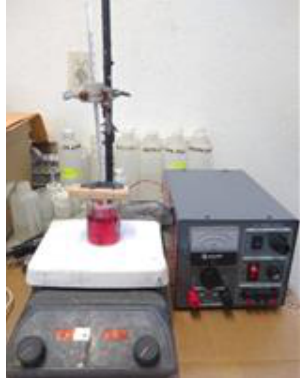
Figure 3. System for electrodeposition of cobalt.